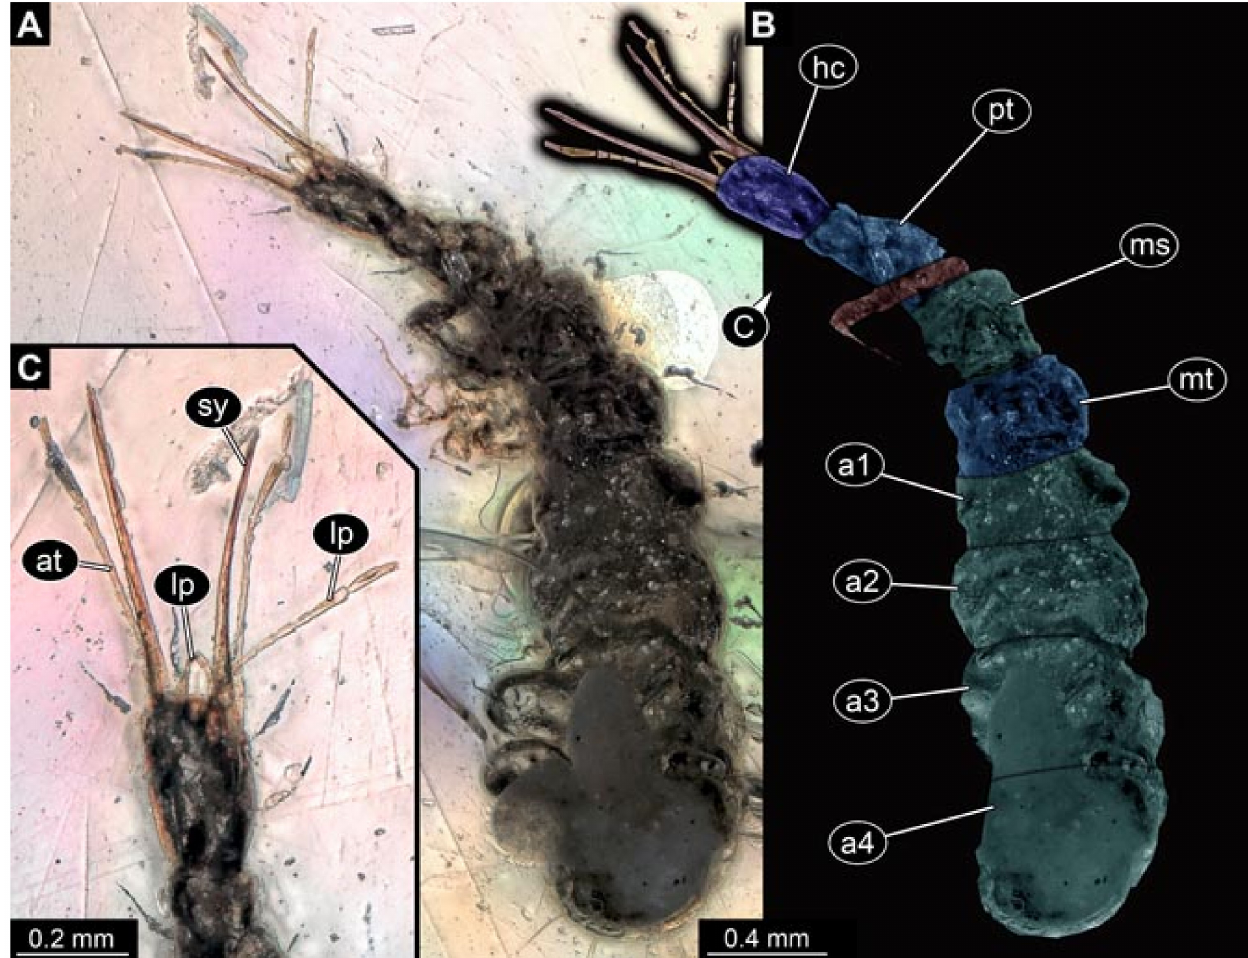
Figure 27. Specimen 5858 (BUB 3368); Myanmar amber. ( A ) Ventral view. ( B ) Ventral view, colour-marked. ( C ) Close-up of head capsule in ventral view. Abbreviations: a1–a4 = abdomen segments 1–4; at = antenna; hc = head capsule; lp = labial palp; ms = mesothorax; mt = metathorax; pt = prothorax; sy =